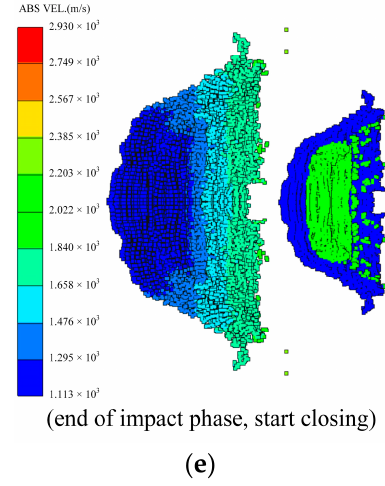
Figure 6. Impact phase: ( a ) t = 2 μ s; ( b ) t = 8 μ s; ( c ) t = 12 μ s; ( d ) t = 17 μ s; ( e ) t = 20 μ s.